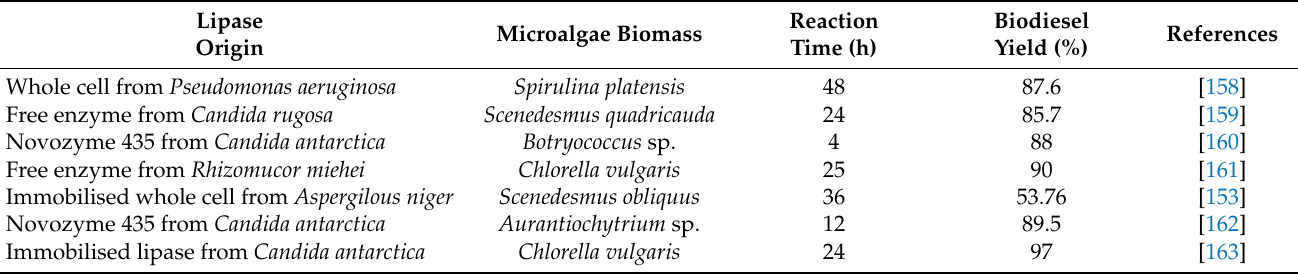
Table 5. Biodiesel yields for several biocatalysts with respect to the microalgae